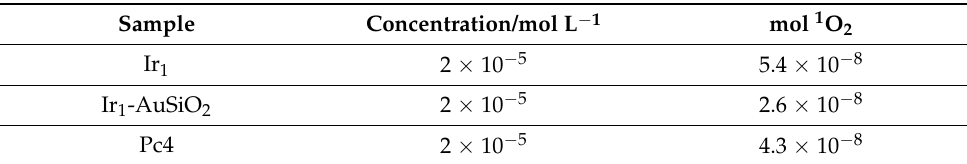
Table 1. Moles of 1 O 2 generated after light exposure of Ir 1 , Ir 1 -AuSiO 2 and Pc4 ( λ ex 365 nm— 20 mW/cm 2 —15